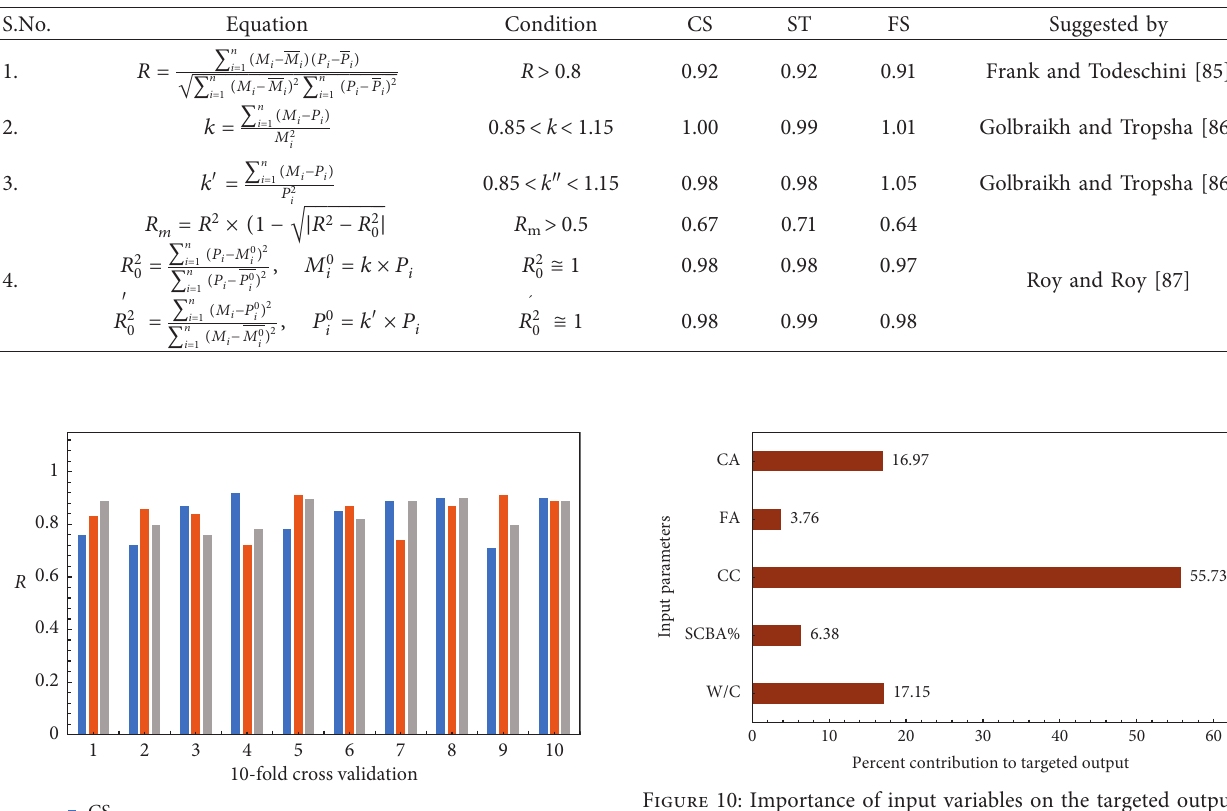
Table 7: Statistical indicators of verified models for external predictability.